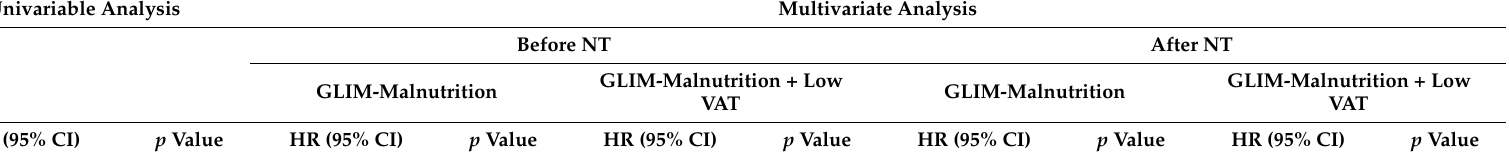
Table 6. Univariate and multivariate analysis for prognostic factors for disease-free survival. Univariable